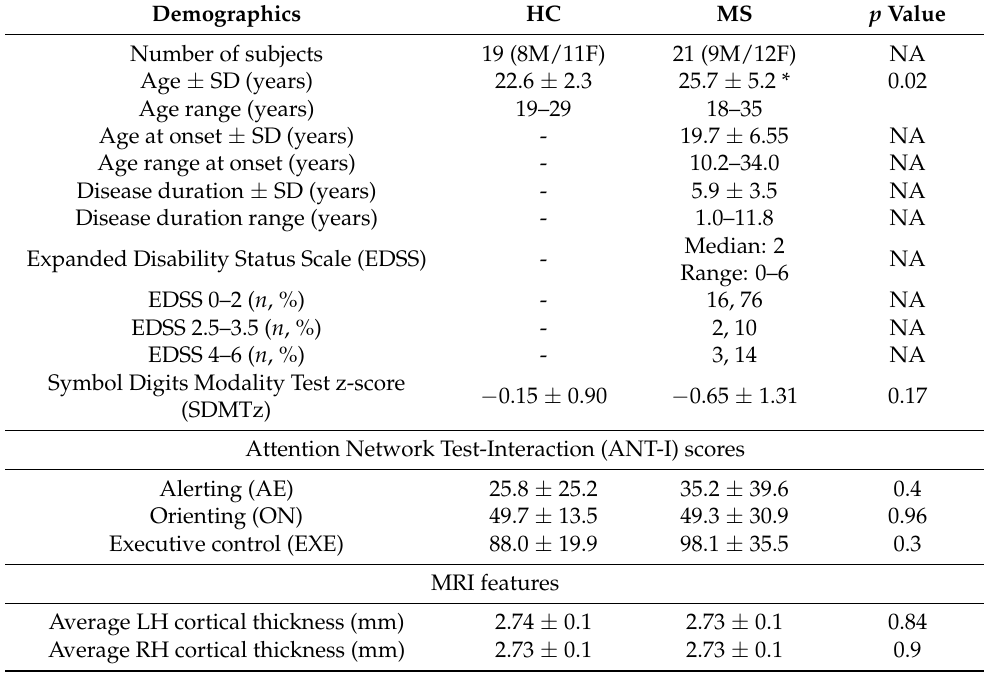
Table 1. Demographic and clinical characteristics of healthy controls (HC) and multiple sclerosis (MS) participants.